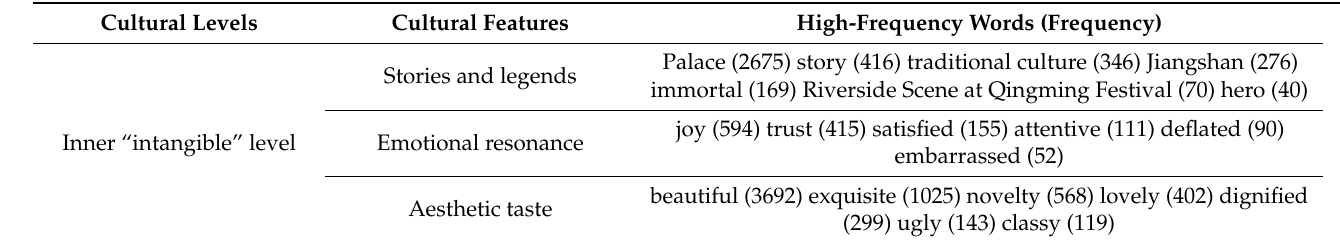
Table 4. Classification of high-frequency